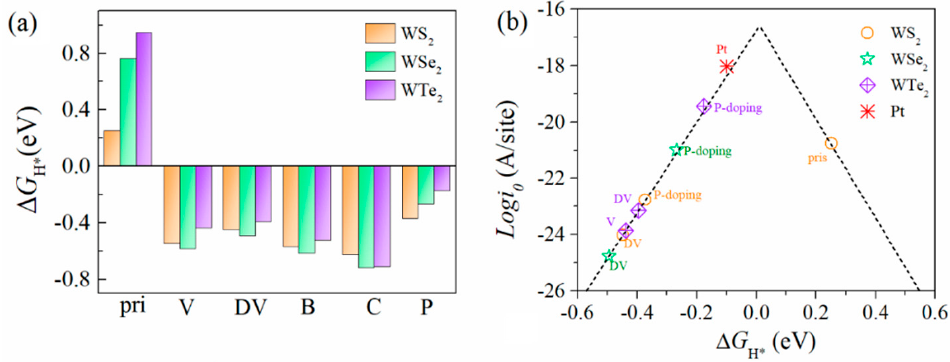
Figure 6. ( a ) Values of Δ G H* and ( b ) the volcano curve between the exchange current density i 0 and the Δ G H* for the T’ − WS 2 , WSe 2 , and WTe 2 monolayers with the various defect types.